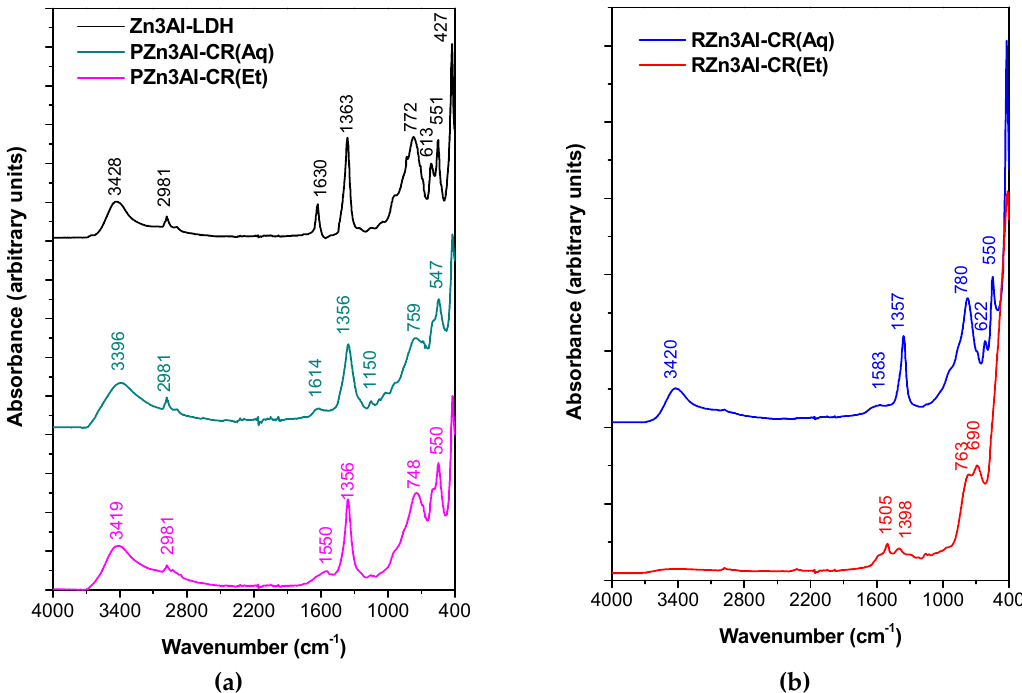
Figure 5. Normalized attenuated total reflectance (ATR)-FTIR spectra: ( a ) precipitated samples Zn3Al-LDH, PZn3Al-CR(Aq), PZn3Al-CR(Et); ( b ) reconstructed samples RZn3Al-CR(Aq), RZn3Al-CR(Et).